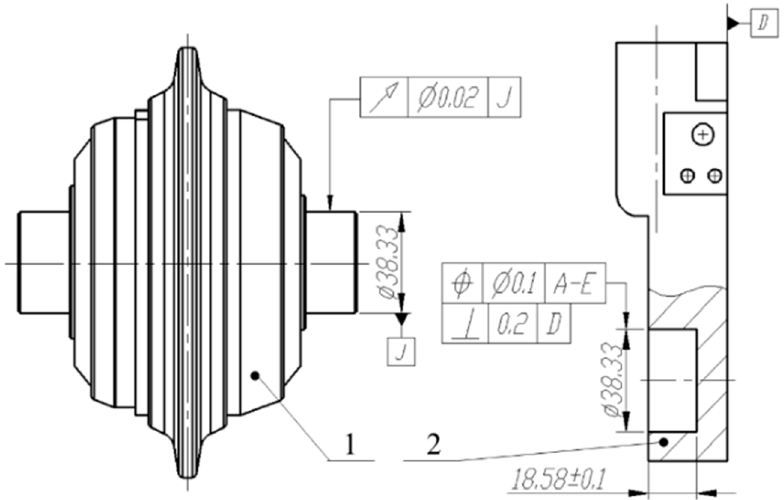
Figure 5. Tolerance of disc cutter and cutter holder. 1—Disc cutter, 2—Cutter holder.